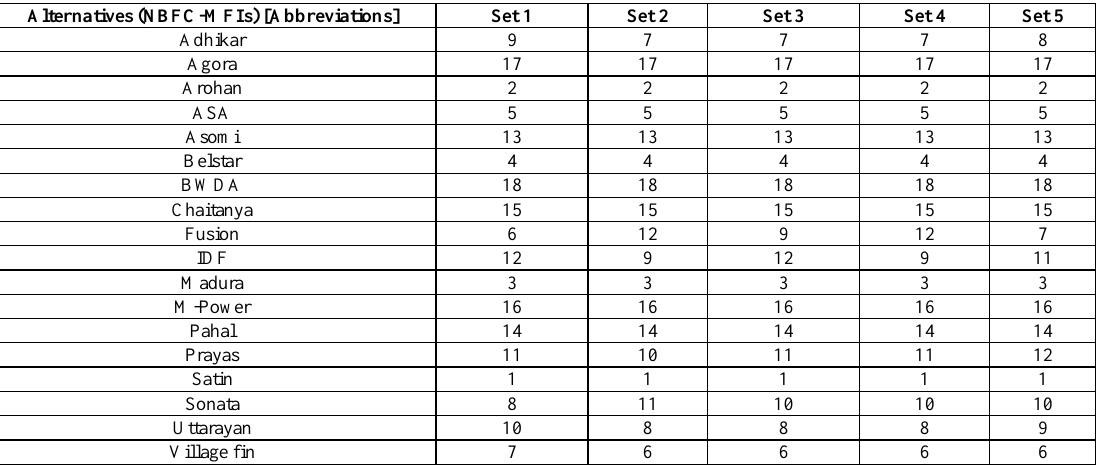
Table 6. Rank of NBFC-MFIs with sensitivity